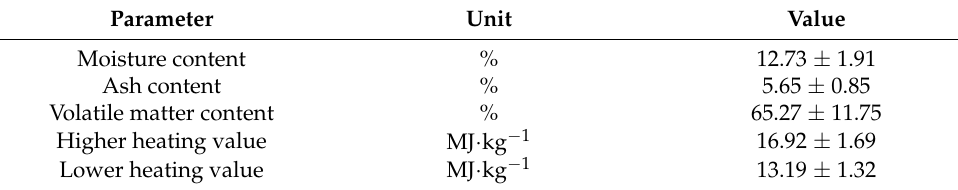
Table 6. Results of the analysis of wheat bran.